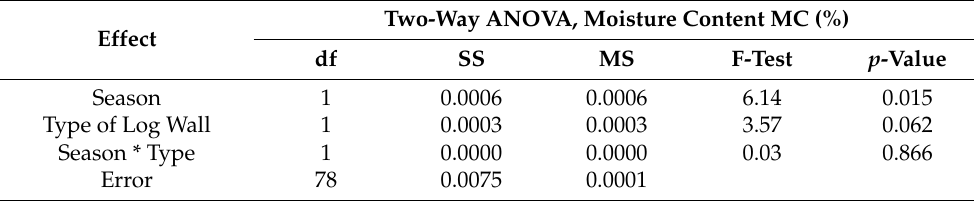
Figure 14. 95% Confidence Intervals for Mean Moisture Contests of STEICO Flex part 1. Statistical analysis of STEICO Flex part 2 was done in STATISTICA ® software, results shown in Table 5 and Figure 15. Table 5. Results of ANOVA for the insulation STEICO Flex part 2 width 45 mm.